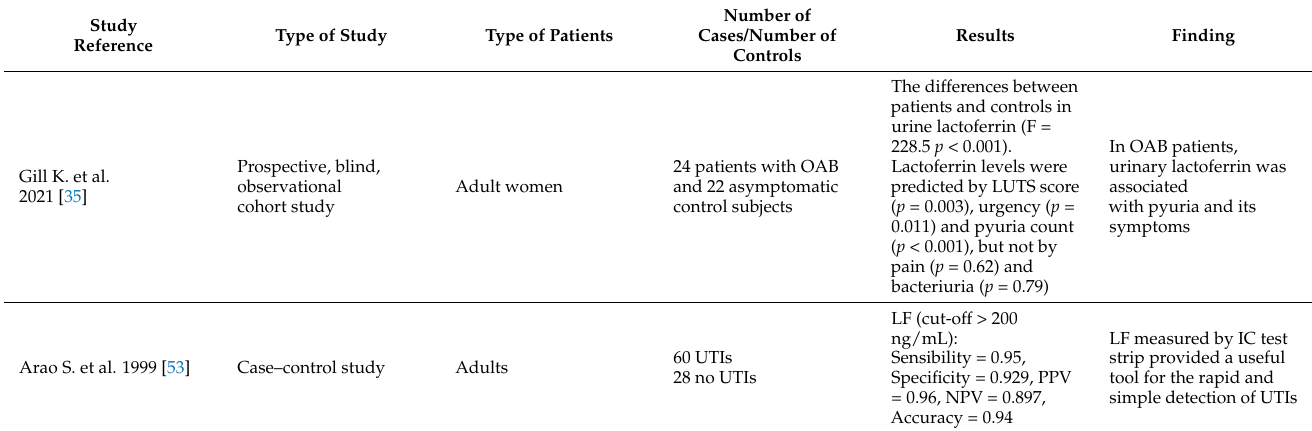
Table 8. Urine lactoferrin diagnostic value in UTIs; target population: